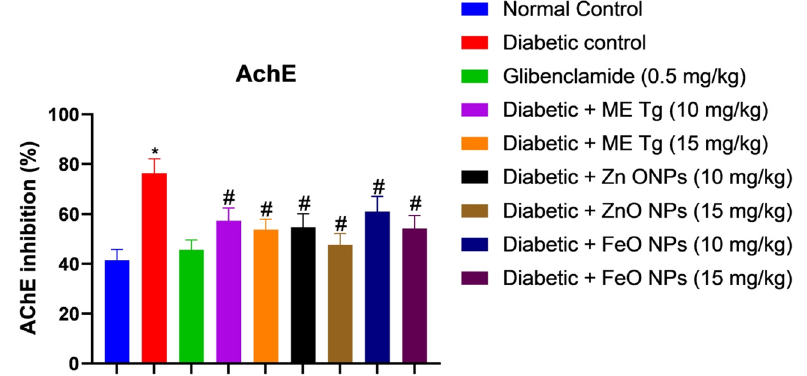
Figure 2: E ff ect of T. glabra methanolic extract and their mediated ZnO NPs and Fe 2 O 3 NPs on AChE activity in the blood of diabetic rats. The data ( n = 5 ) showing as mean ± SEM, showing signi fi cance at * p < 0.05: normal control vs diabetic control; # p < 0.05: diabetic control vs treated groups. METg ( methanolic extract of T. glabra )